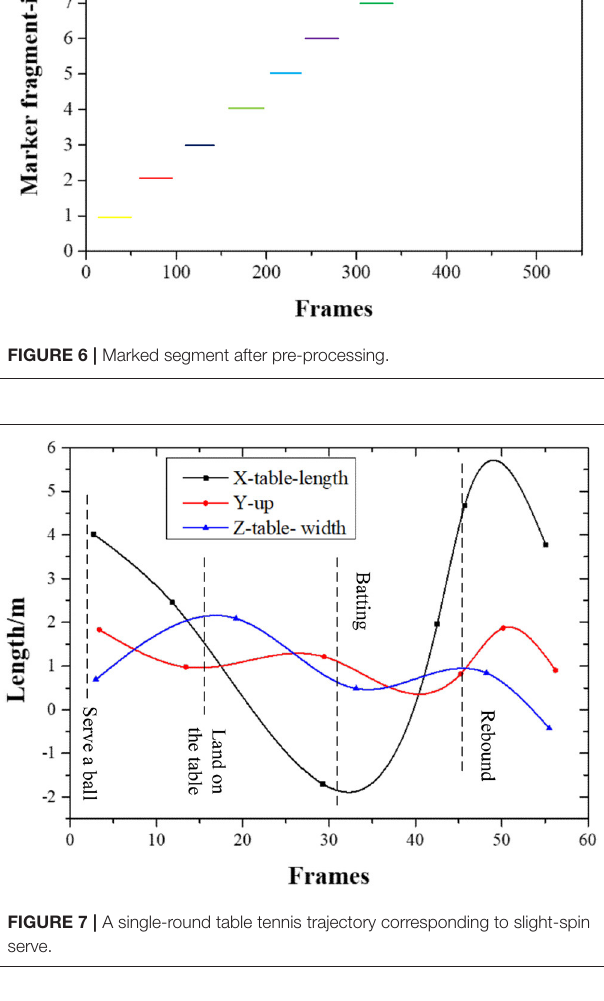
the length of the table. When a missed serve occurs, the ball of the trajectory. The sag appears in the trajectory on the X-axis to the net.